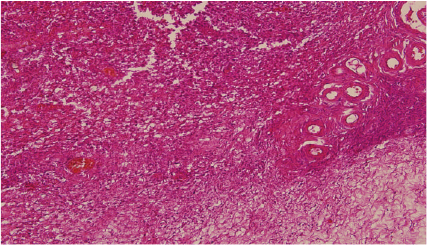
Figure 1: Tumor cells infiltrating the ovarian tissue. Diffuse growth pattern of tumor cells (H&E, × 10 magnification).